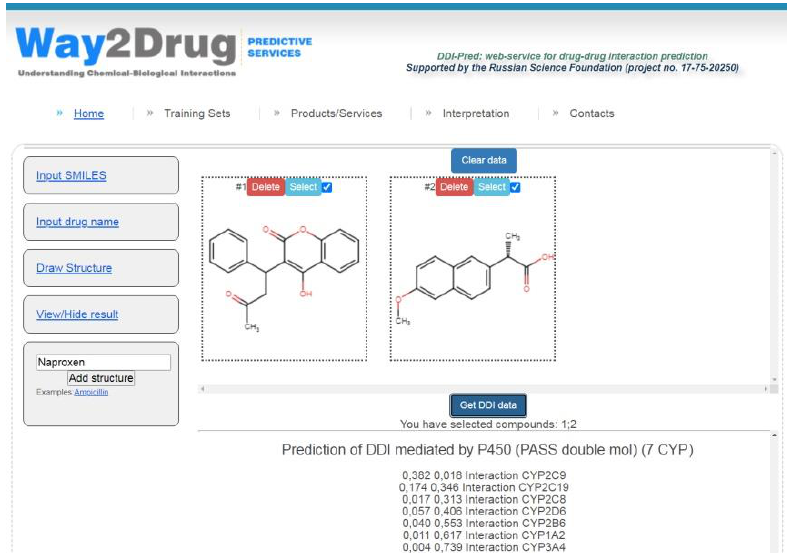
Figure 2. DDI prediction for warfarin and naproxen performed using the web service [20]. The results of the prediction displayed in the block “Prediction of DDIs